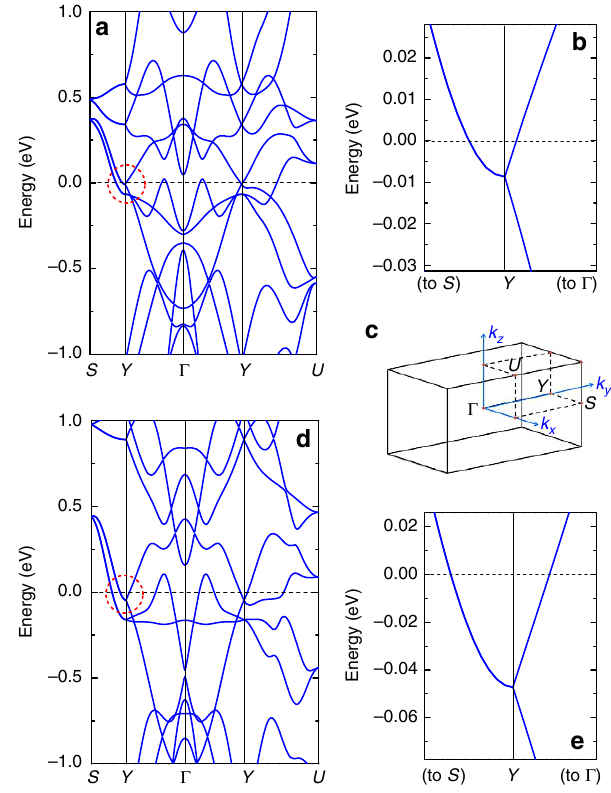
Figure 3 | Comparison of the band structure of CrAs at 14.3kbar and CrP. ( a , b ) Dispersion relation along several high-symmetry directions for CrAs at 14.3kbar. An expanded view of the band structure near E F around Y (indicated by the circle) is shown, where a band crossing is found B 8.6meV below the Fermi energy. The dispersion is linear along Y – G and parabolic along Y – S . ( c ) The first Brillouin zone of CrAs/CrP with the relevant high-symmetry points labelled. ( d , e ) Dispersion relation for CrP. A similar band structure is found in CrP near Y , but with a crossing point located at B 47meV below E F instead.